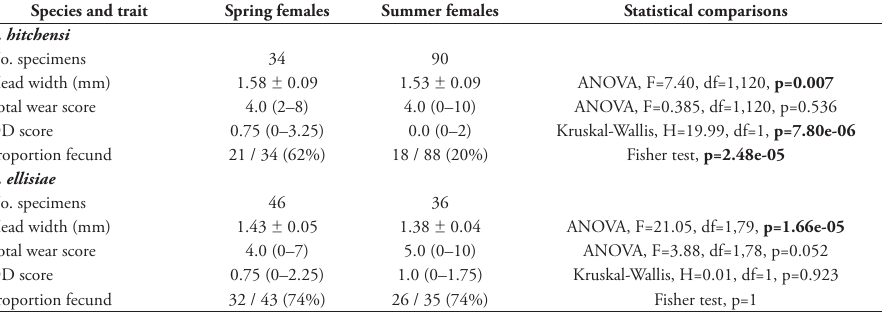
Table 3. Body size and reproductive traits of L. hitchensi and L. ellisiae females with statistical compari- sons between spring and summer. Head width is given as the mean and standard deviation. Total wear and ovarian development scores are given as the median and range. Statistical comparisons are for spring versus summer